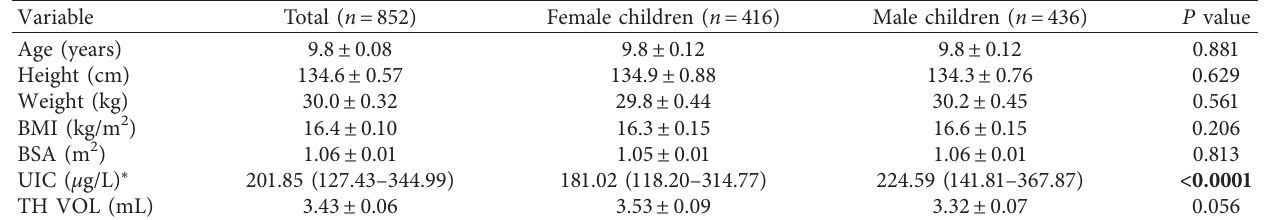
Table 1: Descriptive summary of demographic, anthropometric, and biochemical value of participants by sex.